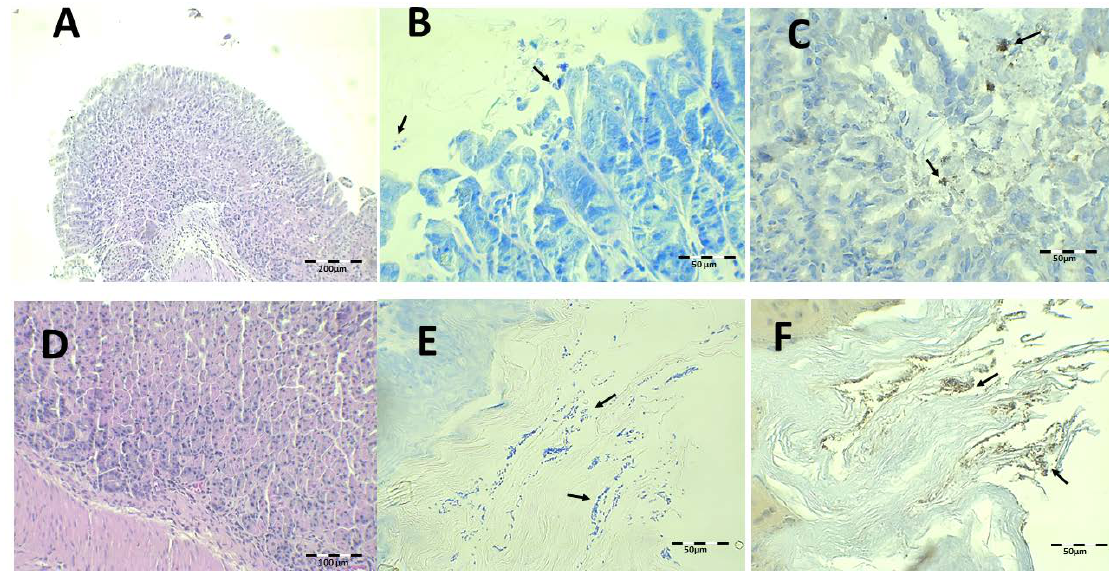
Figure 14. Infected animals treated with 44.7 mg/kg/day of Amox and 22.35 mg/kg/day of Clar in Mucolast ® micropho- tographs of the stomach ( A – D ) and esophagus ( E , F ), stained with H-E ( A , C ), Giemsa ( B , E , arrows indicate H. pylori bacteria), and IHC ( C , F , arrows indicate H. pylori